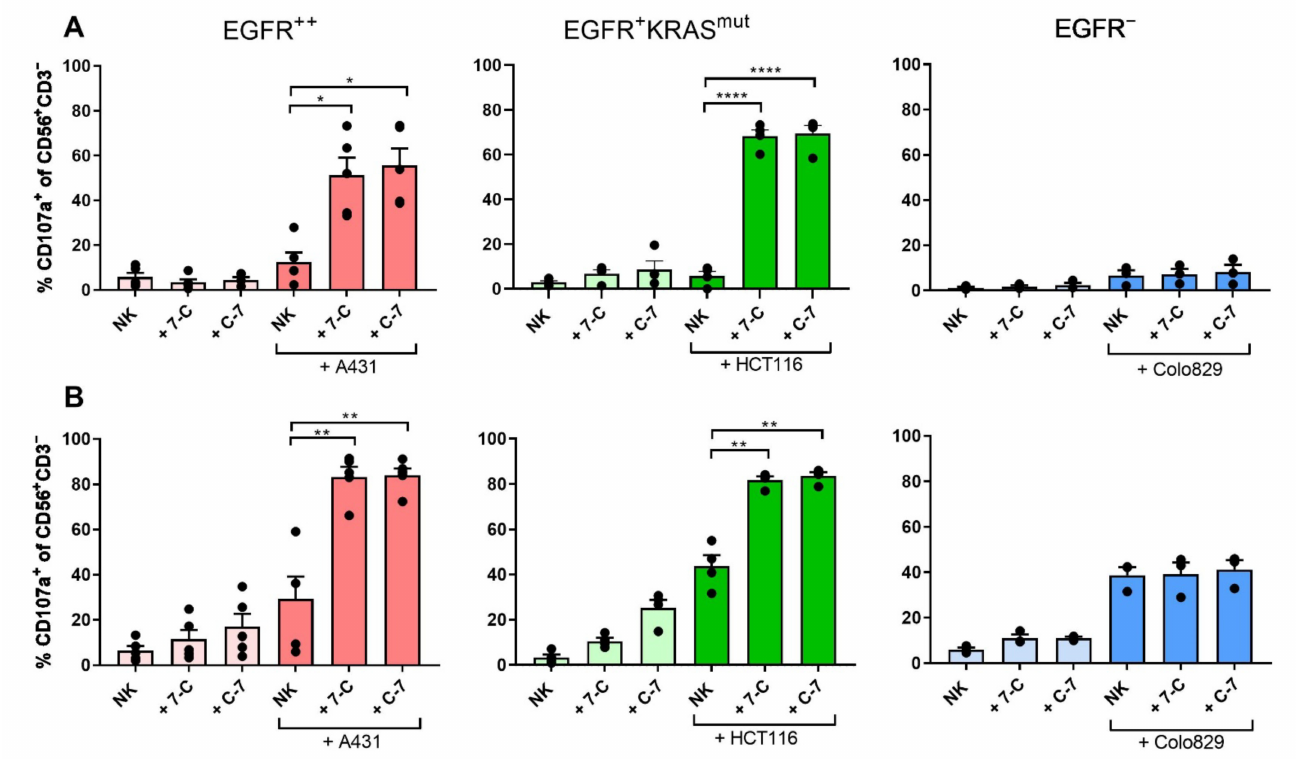
Figure 2. CD16-EGFR bispecific VHHs induce degranulation of NK cells in the presence of EGFR-expressing tumor cells. Degranulation of healthy donor-derived NK cells after a 4-h co-culture ± 100 nM bispecific VHHs ± tumor cell lines expressing different levels of EGFR: A431 (EGFR ++ ), HCT116 (EGFR + RAS mut ), Colo829 (EGFR − ). ( A ) Resting NK cells were used as effectors; ( B ) NK cells were pre-activated overnight with IL-2 and IL-15. Degranulation was determined by assessing the percentage of CD107a + cells. E:T ratio: 1:1. The bars represent mean ± SEM. Significance is presented as p < 0.05 *, <0.01 **, <0.0001 ****. A431 n = 5 ( A , B ); HCT116 n = 4 ( A , B ); Colo829 n = 3 ( A , B ). p -values were determined by two-tailed paired t -test. Abbreviations: C-7 = C21-7D12 bispecific VHH, 7-C = 7D12-C21 bispecific